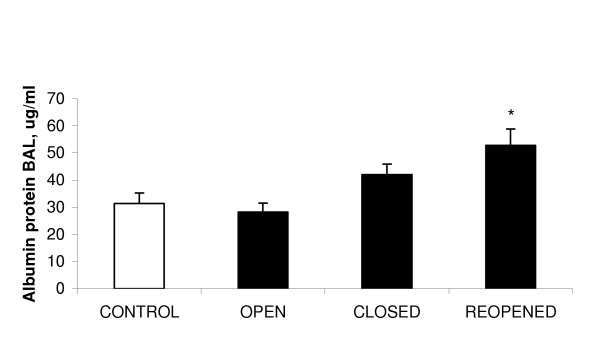
The mean concentration of albumin protein in BAL fluid from lungs exposed to aqueous extracts of PM10 and saline control (* p < 0.05 to control). Values represent the mean of 3 experiments ± SEM.